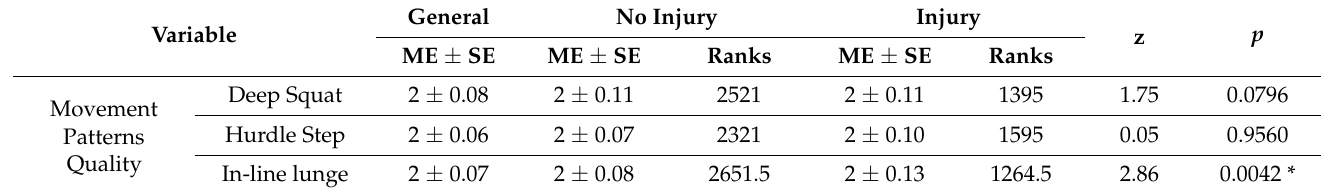
Table 2. U Mann–Whitney test comparison of movement patterns quality tests results.